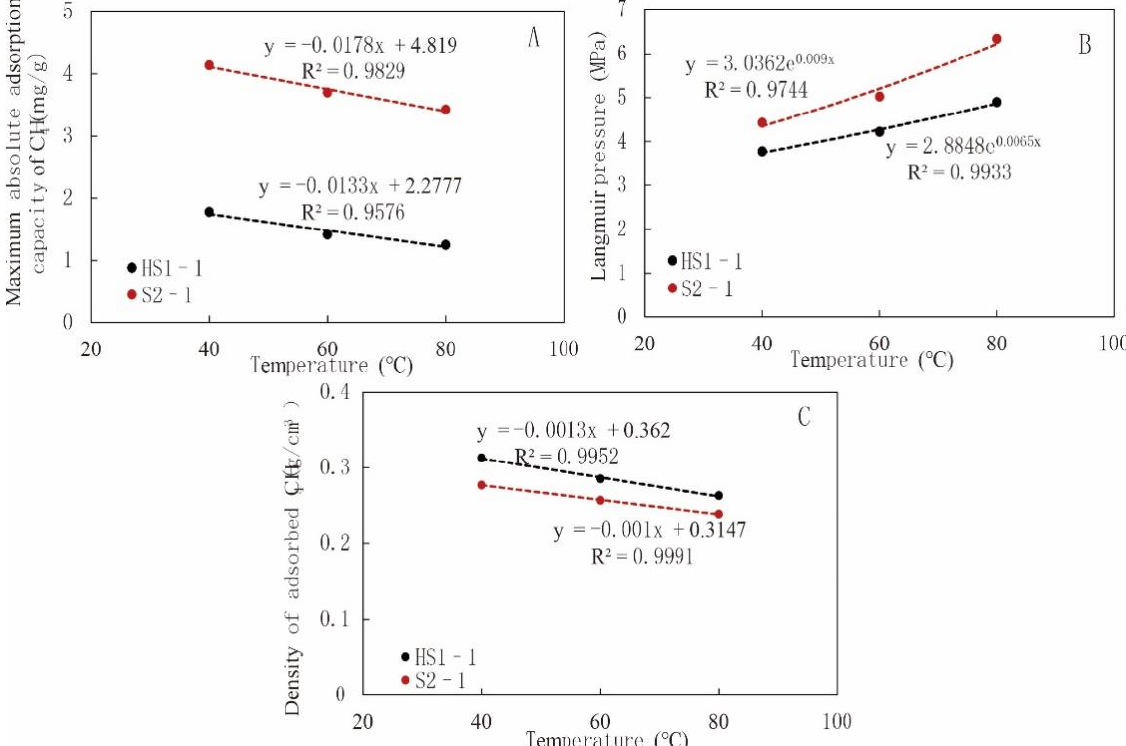
Figure 6. The temperature dependence of maximum absolute adsorption capacity of CH 4 ( A ), Langmuir pressure ( B ), and density of absorbed CH 4 ( C ) fitted by the Langmuir-based excess adsorption model.